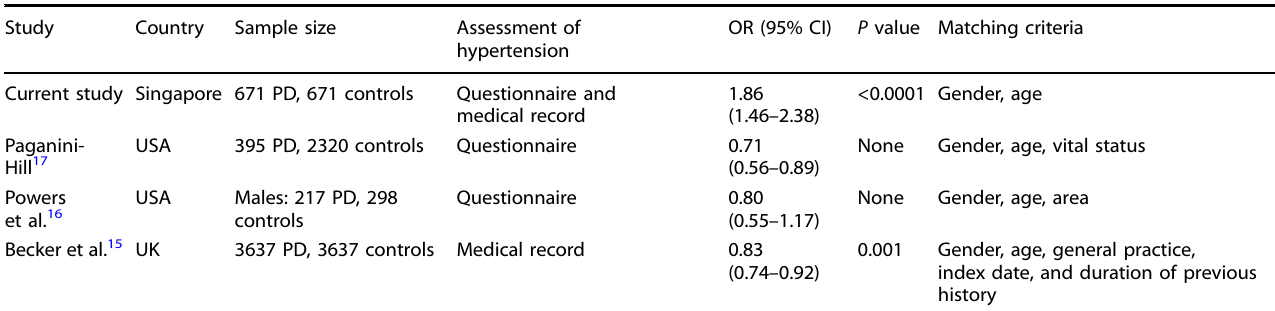
Table 2. Summary of matched case-control studies on the association of hypertension with risk of Parkinson ’ s